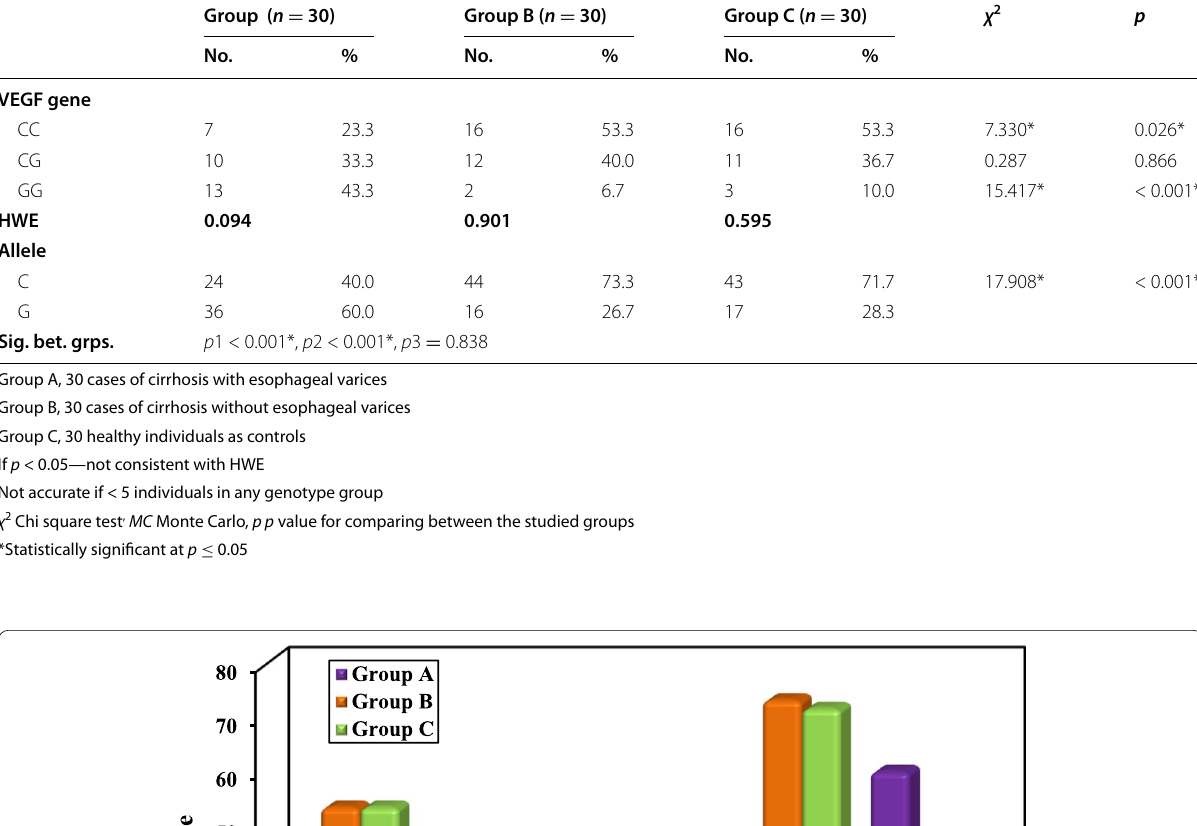
Table 3 Comparison between the three studied groups according to ( VEGF ) C( and whether observed genotype frequencies are consistent with Hardy‑Weinberg equilibrium [23]